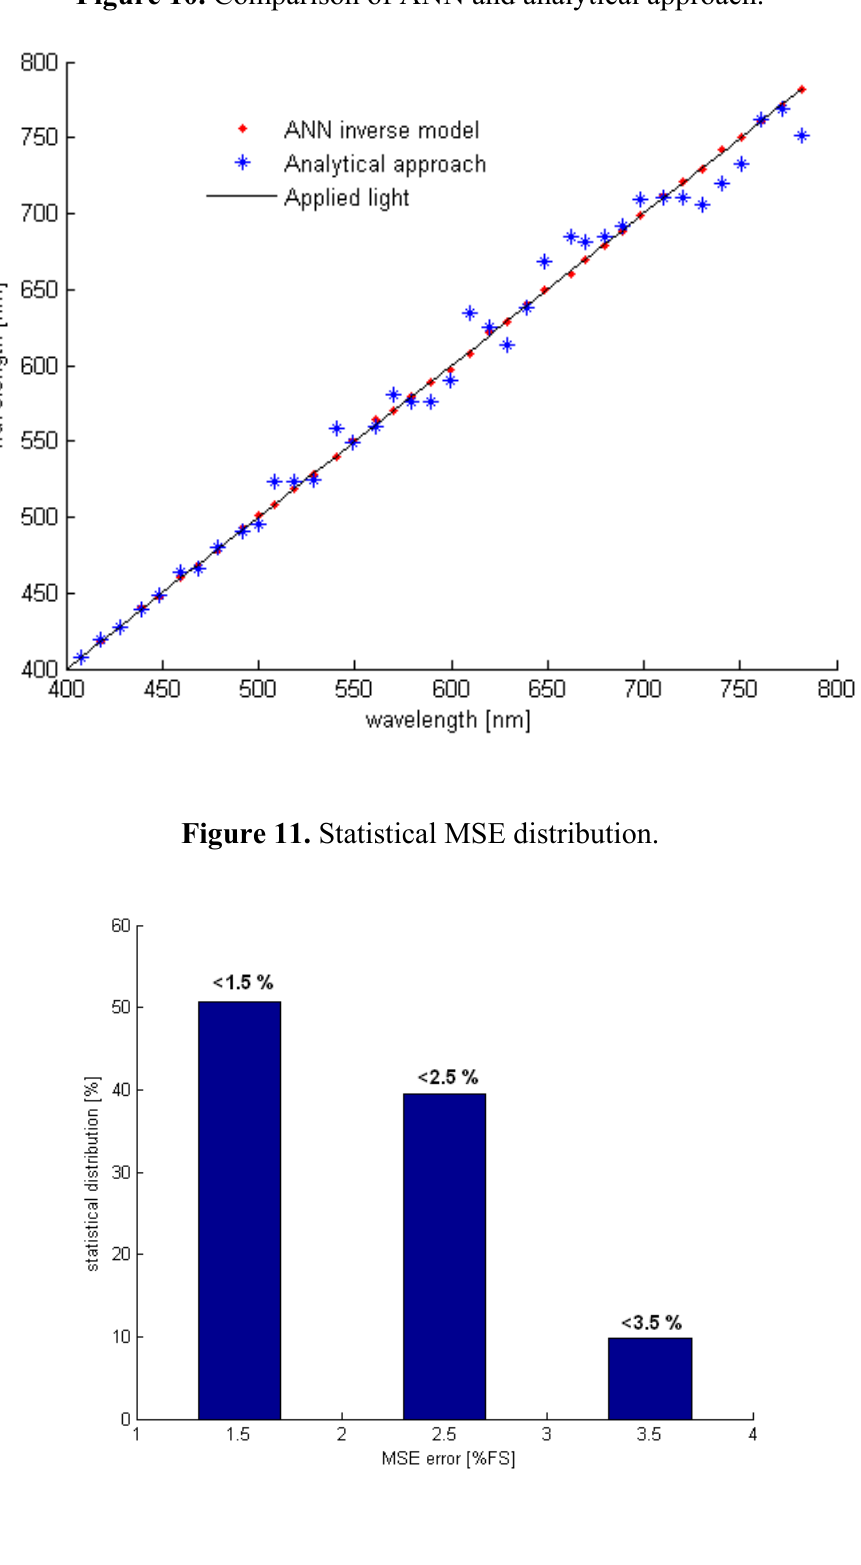
Figure 10. Comparison of ANN and analytical approach.